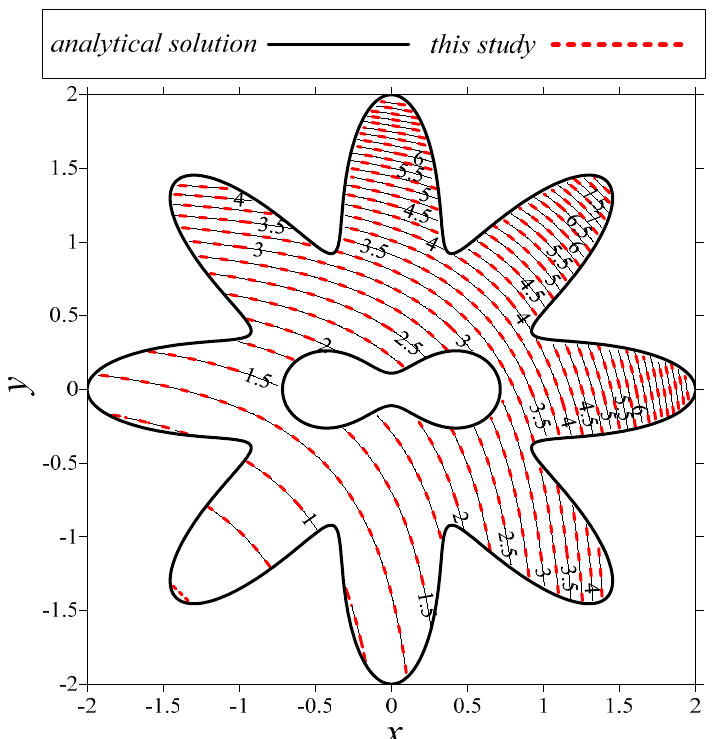
Figure 14. Layout of boundary, source and inner points.